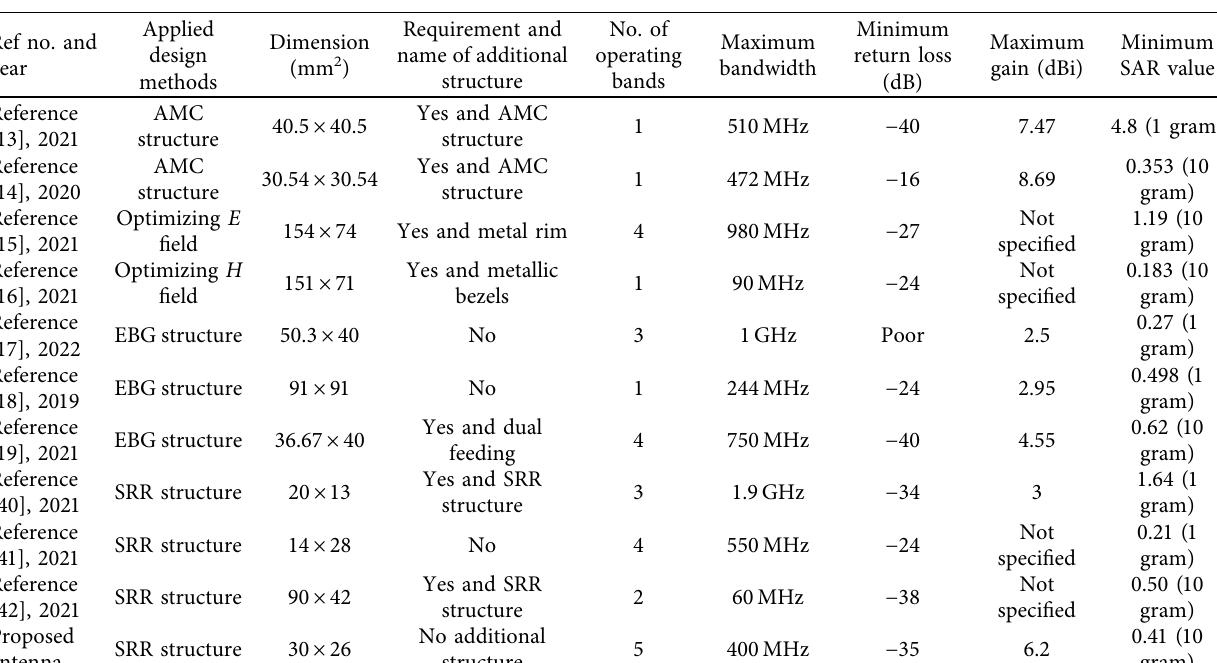
Table 4: Proposed antenna vs. literature